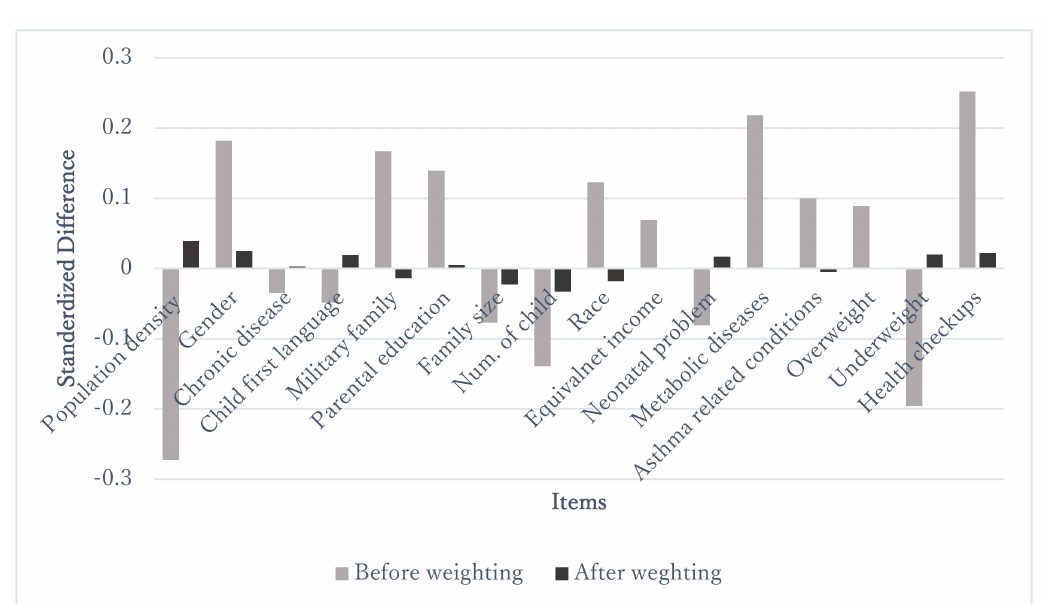
Figure A1. Standardized difference of covariates before and after weighting propensity score. The vertical axis indicates from negative 0.3 to positive